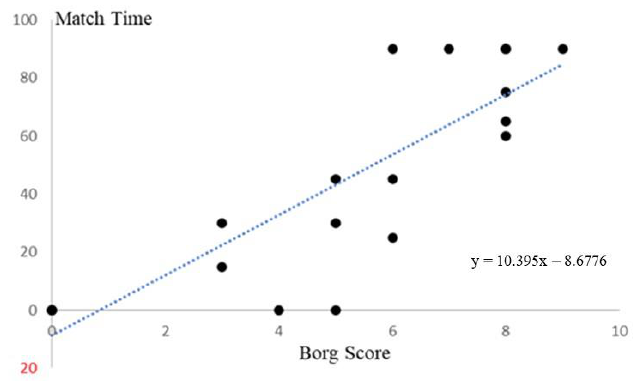
Figure 2. Relationship of Borg scale with match